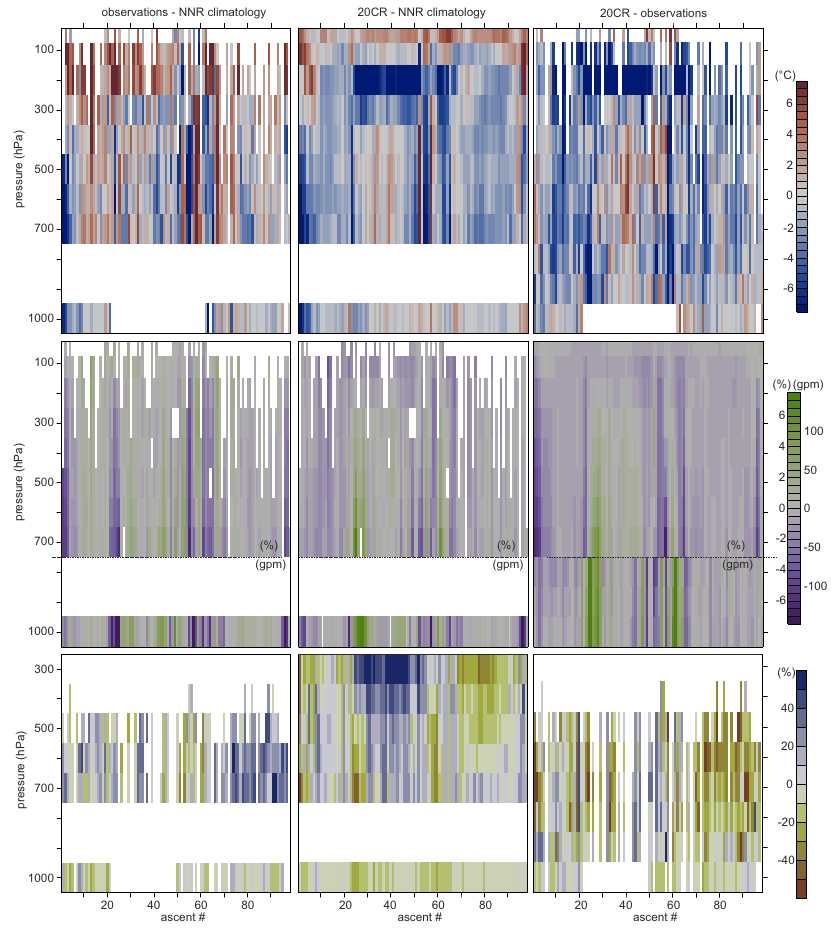
Fig. 6. Vertical profiles from observations and 20CR for the cruise of the MS Schwabenland for temperature (top), GPH (middle) and relative humidity (bottom). (left) Anomalies of observations with respect to NNR climatology, (middle) Anomalies of 20CR with respect to NNR climatology, (right) difference 20CR minus